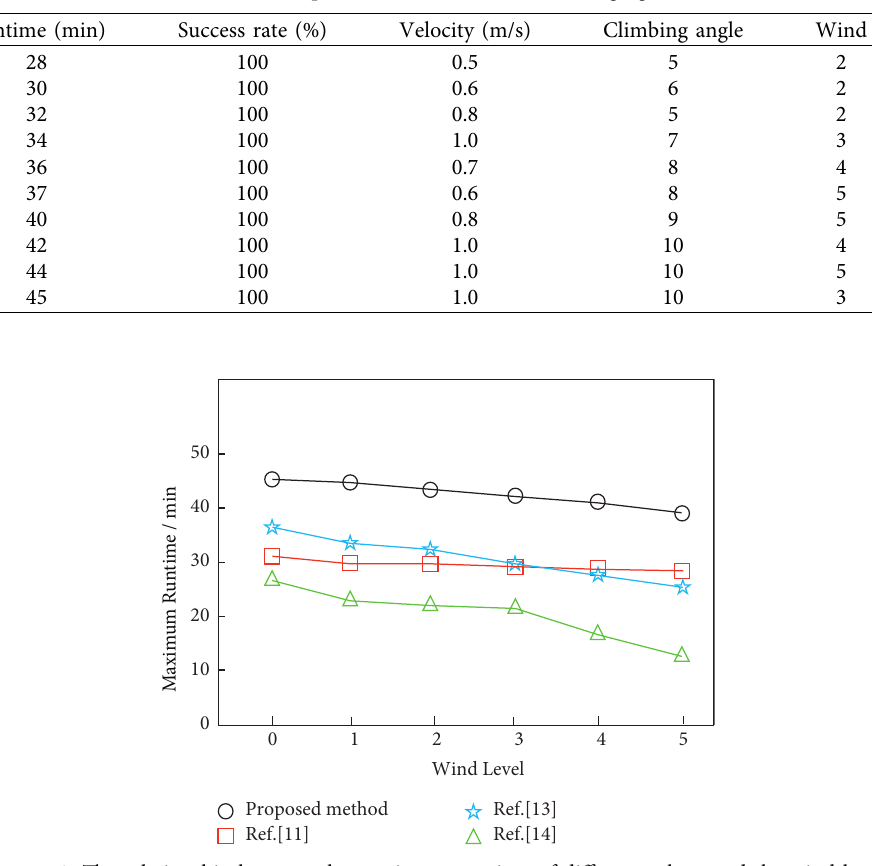
Table 2: The experimental data of the line changing robot.